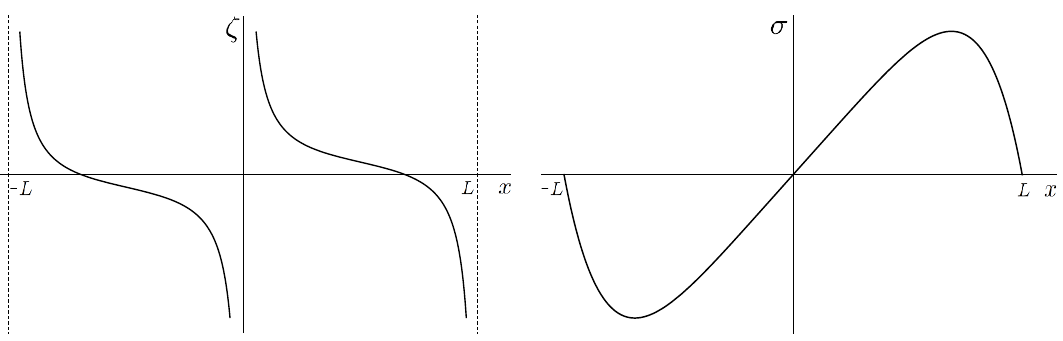
Figure 11. The Weierstrass (cid:16) and (cid:27) functions with P 1 = L; P 2 = i(cid:12) , evaluated on the real line. Integrating (cid:16) along the boundary of a cell and using the above quasiperiodicity property, one